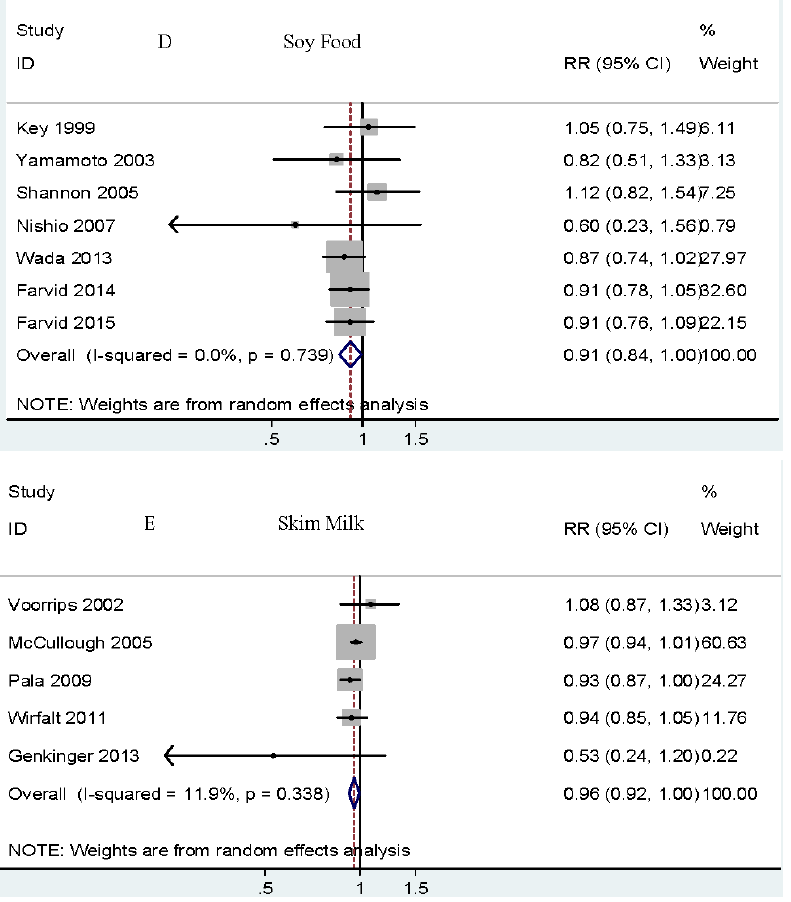
Figure 2. Dose ‐ response analysis of total red meat, fresh red meat, processed meat, soy foods, and skim milk intake and the risk of breast cancer. ( A ) Dose ‐ response analysis of total red meat intake and the risk of breast cancer. ( B ) Dose ‐ response analysis of fresh red meat intake and the risk of breast cancer. ( C ) Dose ‐ response analysis of processed meat intake and the risk of breast cancer. ( D ) Dose ‐ response analysis of soy foods intake and the risk of breast cancer. ( E ) Dose ‐ response analysis of skim milk intake and the risk of breast cancer. Overall, relative risk calculated with random effects model. As shown in the figure, total red meat (A), fresh red meat (B), and processed red meat (C) are related to increased breast cancer risk, whereas soy food (D) and skim milk (E) are related to a decreased risk of breast cancer.